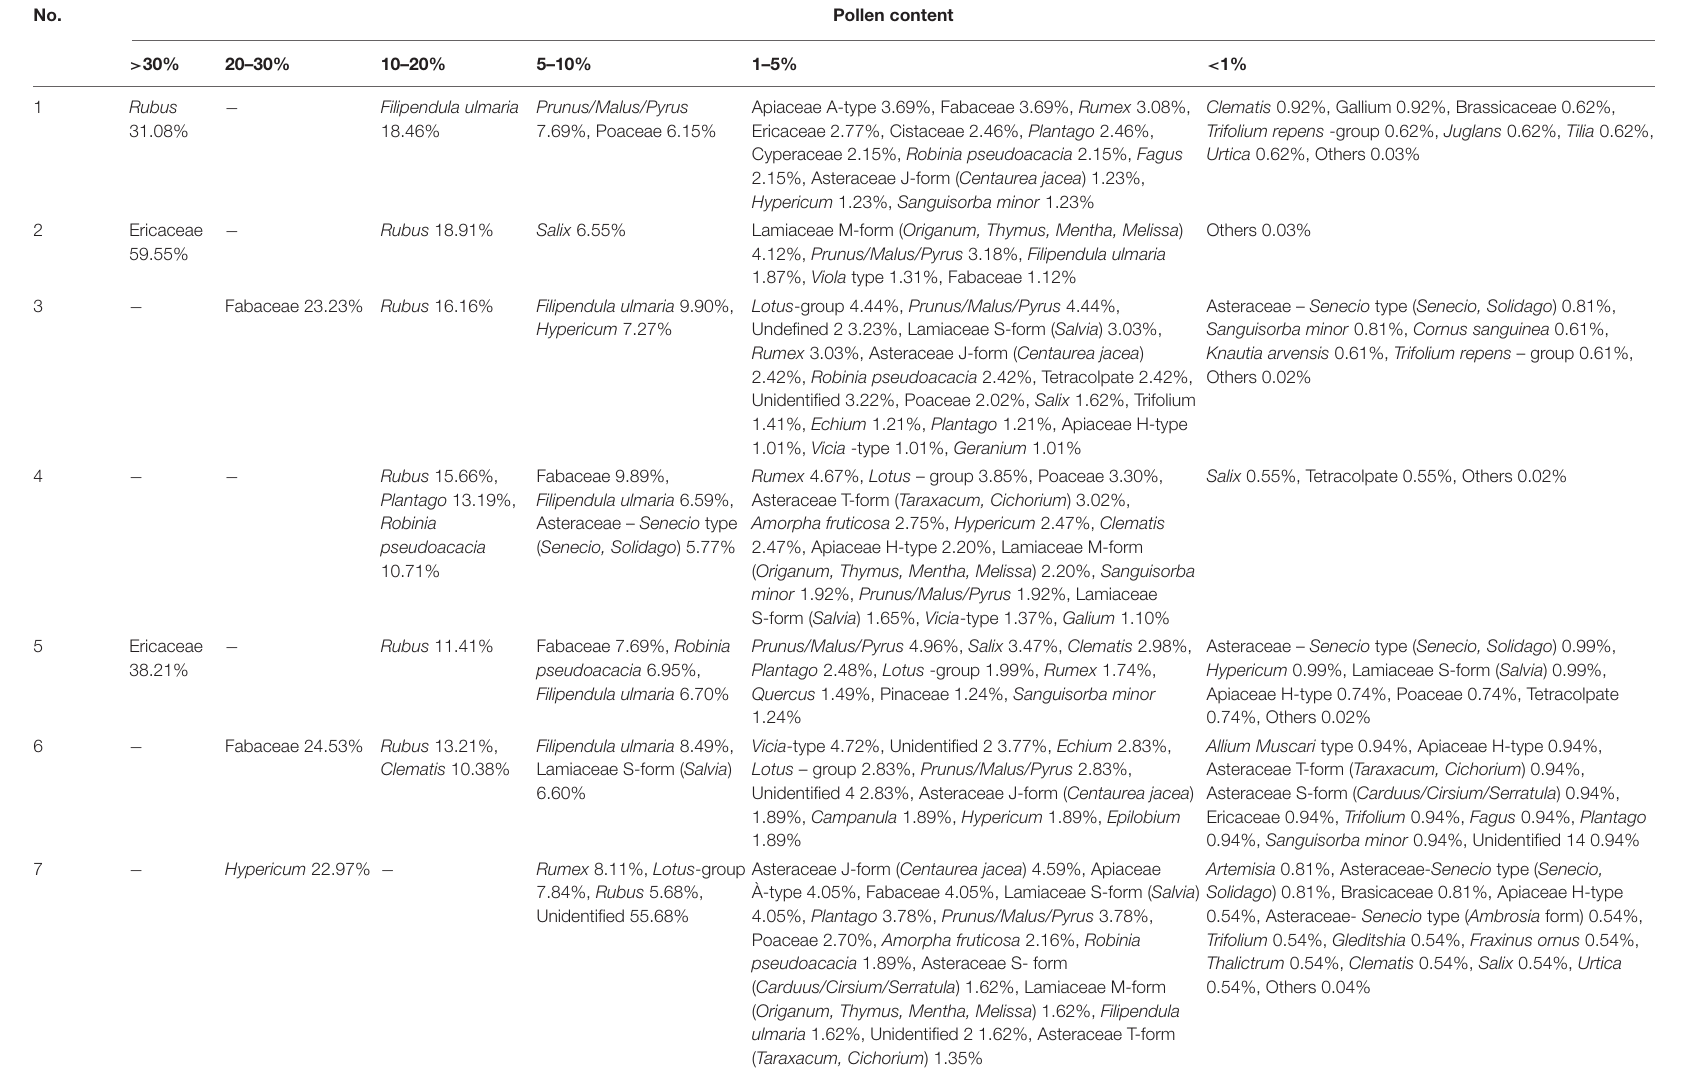
TABLE 4 | Melissopalynological analyses of honey samples from the Tara Mountain region in Serbia.